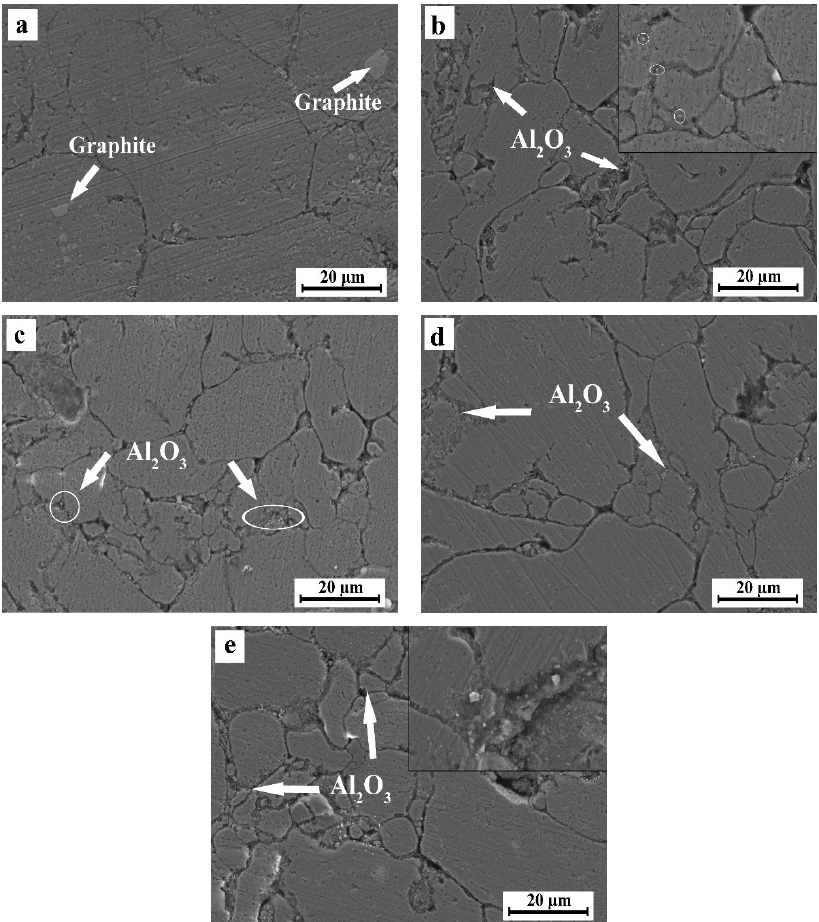
Figure 1: Microstructural SEM images of composite materials with different amounts of Al 2 O 3 reinforcement; Al+2Gr (a), 3% Al 2 O 3 (b), 6%